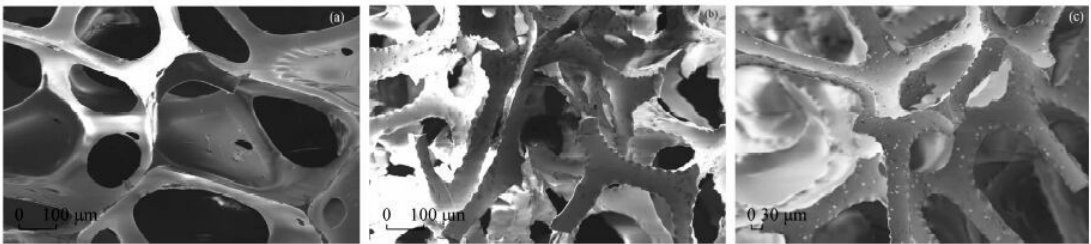
Figure 5. Scanning electron microscopy images of ( a ) PUF, ( b ) PUF-NH 2 , and ( c ) PUF-NH 2 adsorbed Au. Reprinted with permission from [107].